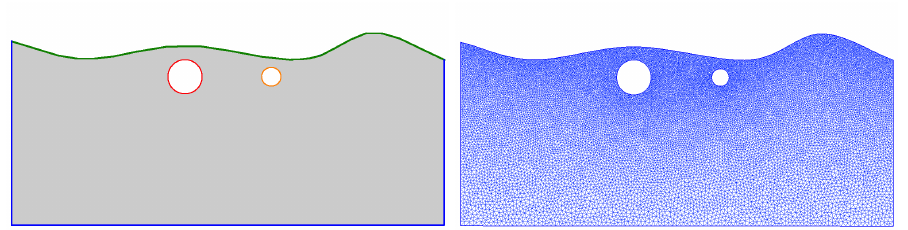
Figure 6. Geometry with unstructured grid. Left : computational domain (gray color), top boundary (green), circle one (red), and circle two (orange). Right: unstructured mesh with triangular